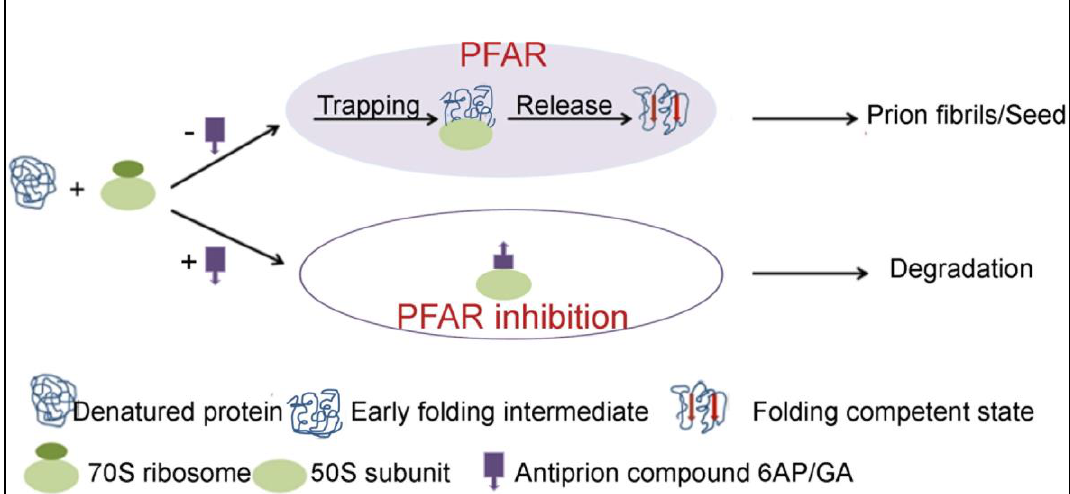
Figure 6. The current model describing involvement of PFAR in prion processes and the role of the antiprion compounds (6AP/GA/other compounds with similar activity) in